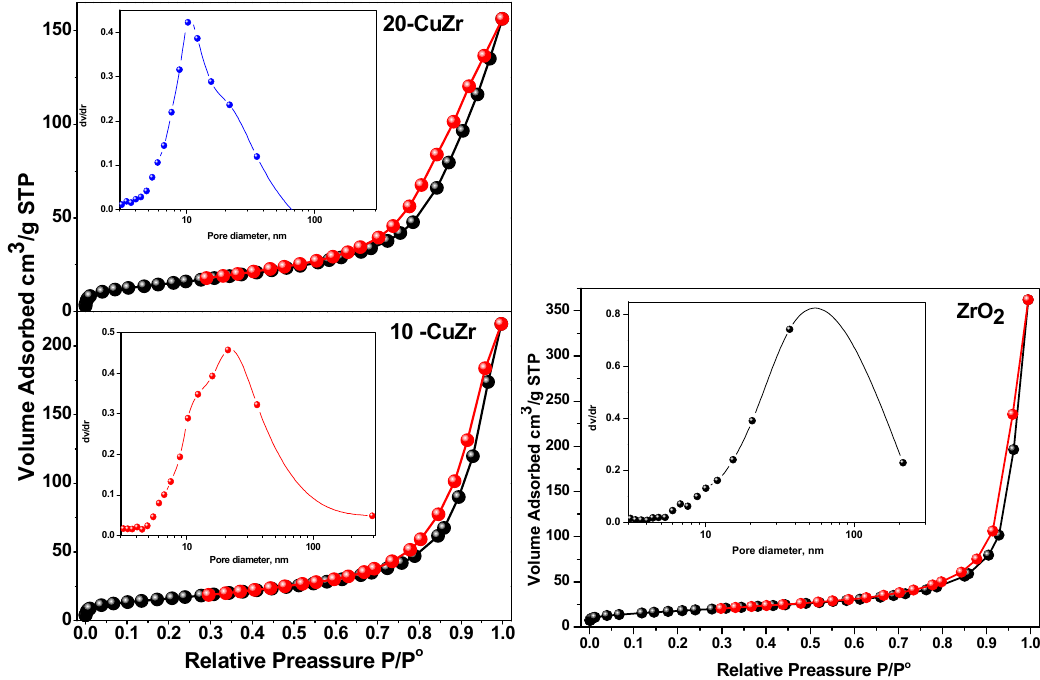
Figure 4. Nitrogen adsorption ‐ desorption isotherms for all the samples (inset pore size distribution patterns). Figure 4 represents N 2 adsorption ‐ desorption isotherms with the pore size distribution patterns Table 2. Results from N 2 -physisorption, ICP-AES and XPS analysis of the samples.